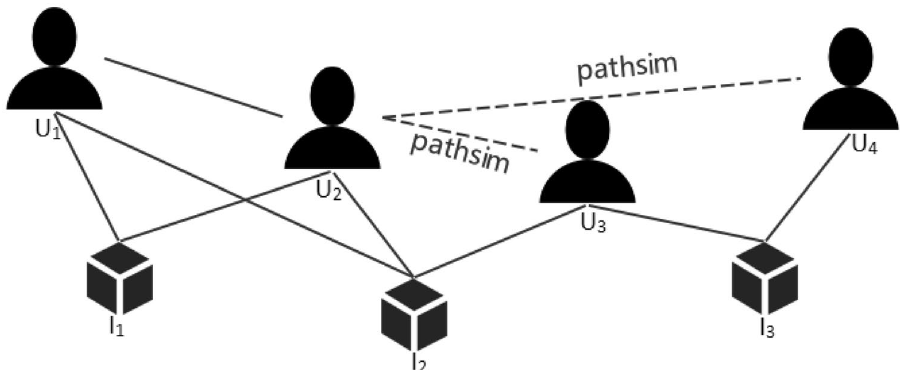
Fig. 3 The PathSim diffused network (the initiator links to the weakly similar users by